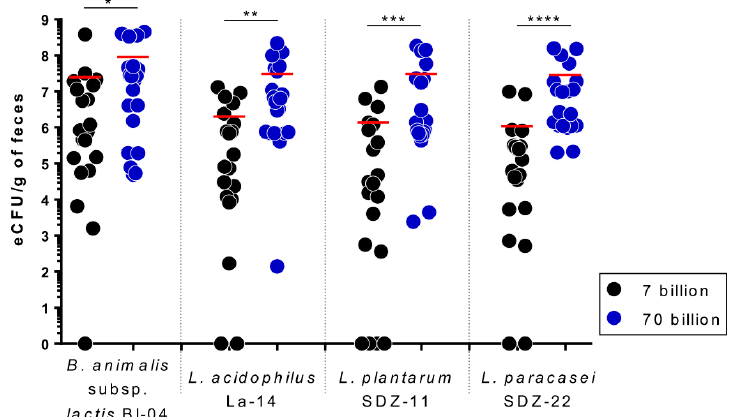
Figure 4. Recovery of viable cells of the probiotic bacterial strains from the feces collected at the end of the two-week intervention (day 14). Data are reported as the estimated minimum CFU number (eCFU; see methods section in the text for details). Statistical analysis was performed according to a two-tailed unpaired t -test; *, p < 0.05; **, p < 0.01; ***, p < 0.001; ***, p < 0.0001.